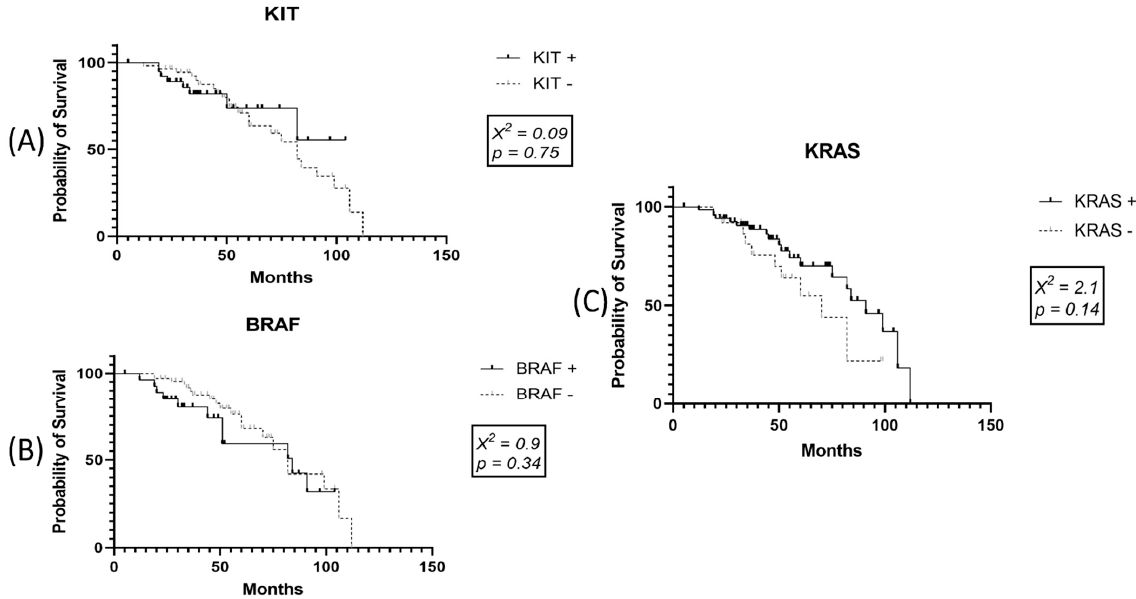
Figure 5. In the present cohort, univariate Kaplan–Meier survival analysis did not sustain an independent prognostic value of ( A ) KIT, ( B ) BRAF, or ( C ) KRAS expression.